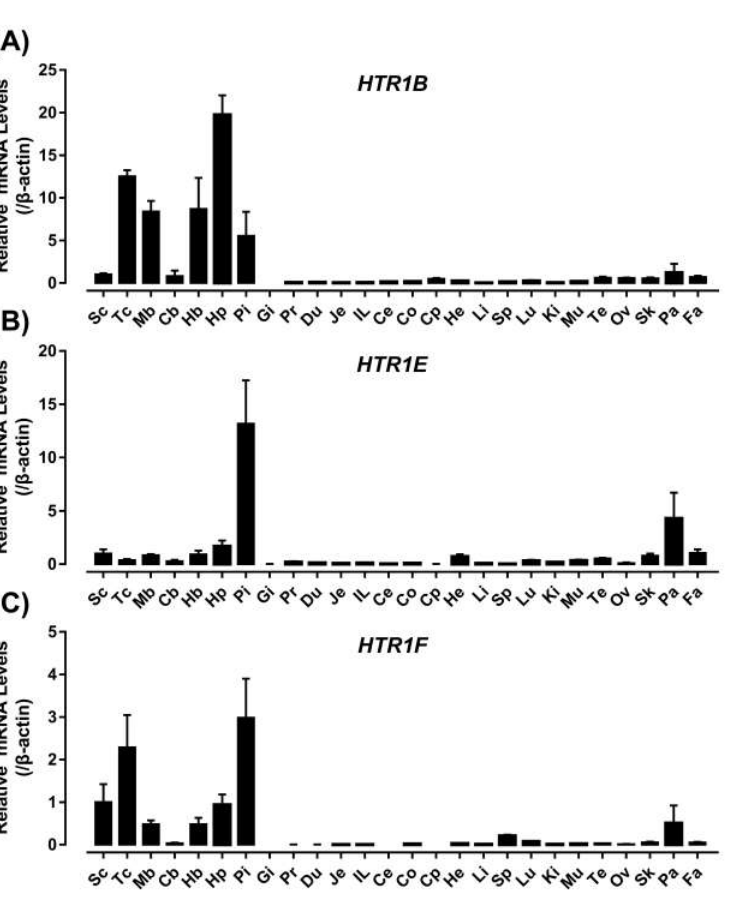
Figure 6. qRT-PCR detection of HTR1B ( A ), HTR1E ( B ) and HTR1F ( C ) in various adult chicken tissues, including the spinal cord (Sc), telencephalon (Tc), midbrain (Mb), cerebellum (Cb), hindbrain (Hb), hypothalamus (Hp), anterior pituitary (Pi), gizzards (Gi), proventriculus (Pr), duodenum (Du), jejunum (Je), ileum (IL), cecum (Ce), colon (Co), crop (Cp), heart (He), liver (Li), spleen (Sp), lung (Lu), kidney (Ki), muscle (Mu), testes (Te), ovary (Ov), skin (Sk), pancreas (Pa), and subcutaneous fat (Fa). β -actin was used as an internal control. The mRNA levels of receptors in chicken tissues were expressed as fold difference compared with that in the spinal cord (Sc). Each data point represents the mean ± SEM of 6 individual adult chickens (3 males and 3 females) ( n =